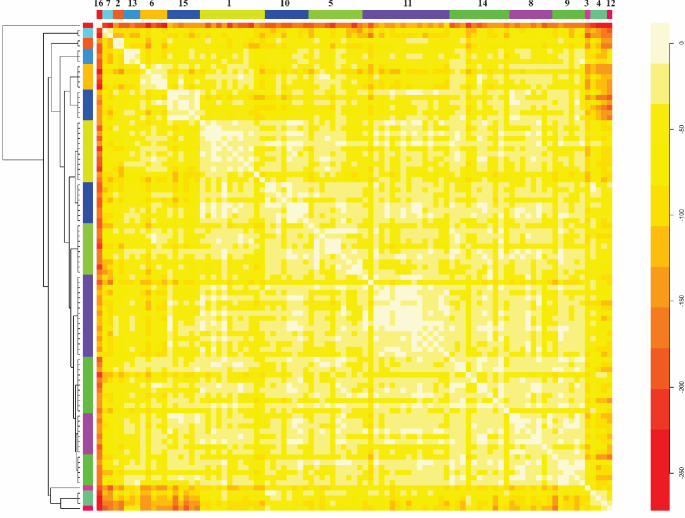
Heatmap and hierarchical clustering of the genetic distances of the C. moschata accessions, based on agro-morphological traits, the total content of fruit pulp carotenoids, and the yields of seeds and seed oil.The coloured bars on the upper and lower axis correspond to the groups obtained in the clustering. The dissimilarity between each pair of accessions and between groups is indicated by the colour, which varies from white to red. Red indicates the pairs of genotypes with the highest dissimilarity and white indicates the pairs of genotypes with lowest dissimilarities.